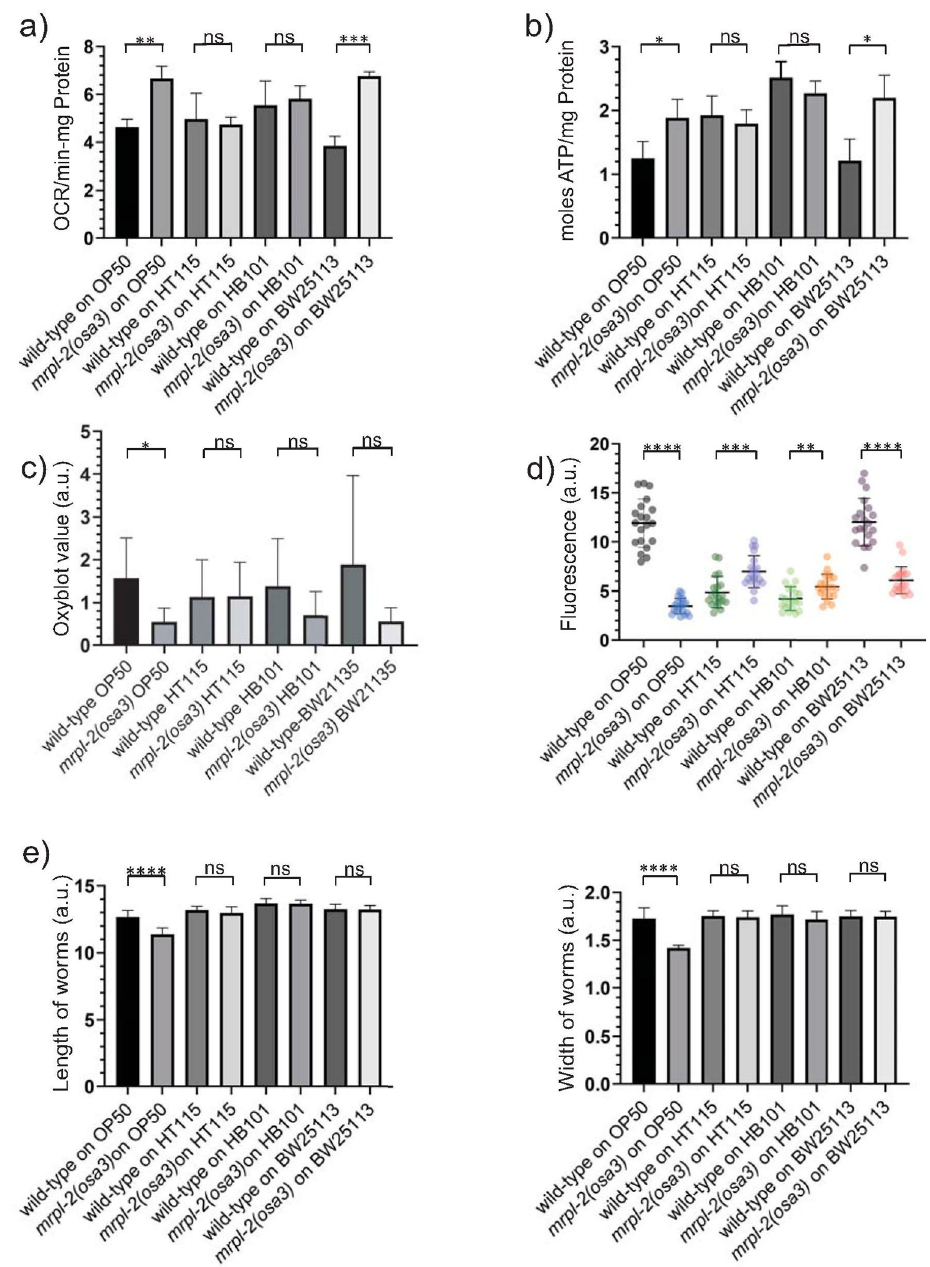
Fig 2. Mitochondrial function is altered in mrpl-2(osa3) animals in a diet-dependent manner. (A) Oxygen consumption rate determination for wild-type and mrpl-2(osa3) animals fed E . coli OP50, HT115, HB101, and BW25113. Oxygen consumption was normalized to total protein content (mean ± SD; n = 3); ns denotes not significant, �� denotes p � 0.01, ��� denotes p � 0.001 (Student’s t test). (B) ATP production quantification for wild- type and mrpl-2(osa3) animals fed E . coli OP50, HT115, HB101, and BW25113. ATP levels are normalized to total protein content (mean ± SD; n = 3); ns denotes not significant, � denotes p � 0.05 (Student’s t test). (C) Oxidative protein modification determination using the OxyBlot assay. OxyBlot values were normalized to actin for each sample and represented as arbitrary units (A.U.). (mean ± SD; n = 5); ns denotes not significant, � denotes p � 0.05 (Student’s t test). (D) Mitochondrial membrane potential determination using TMRE and quantification for wild-type and mrpl- 2(osa3) animals fed E . coli OP50, HT115, HB101, and BW25113 reflected as arbitrary units (A.U.). (mean ± SD; n � 20 worms); �� denotes p � 0.01, ��� denotes p � 0.001, ���� denotes p � 0.0001 (Student’s t test). (E) Animal size quantification of wild-type and mrpl-2(osa3) animals fed E . coli OP50, HT115, HB101, and BW25113. Animal size is expressed as the length and width of each animal and represented as arbitrary units (A.U.); (mean ± SD; n � 20 worms); ns denotes not significant, ���� denotes p � 0.0001 (Student’s t test).